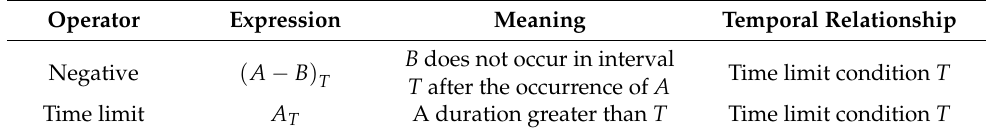
Table 1. Other operators.